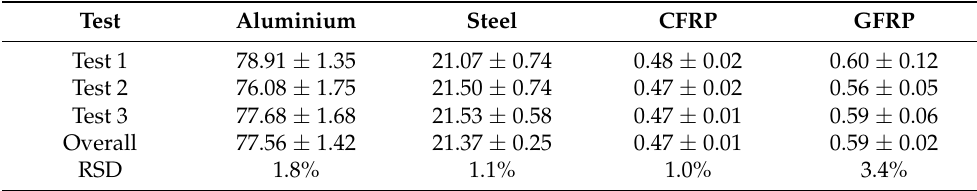
Table 3. Measured thermal diffusivity (mm 2 /s) values with RSD for multiple tests of the same sample using the NLSF method.